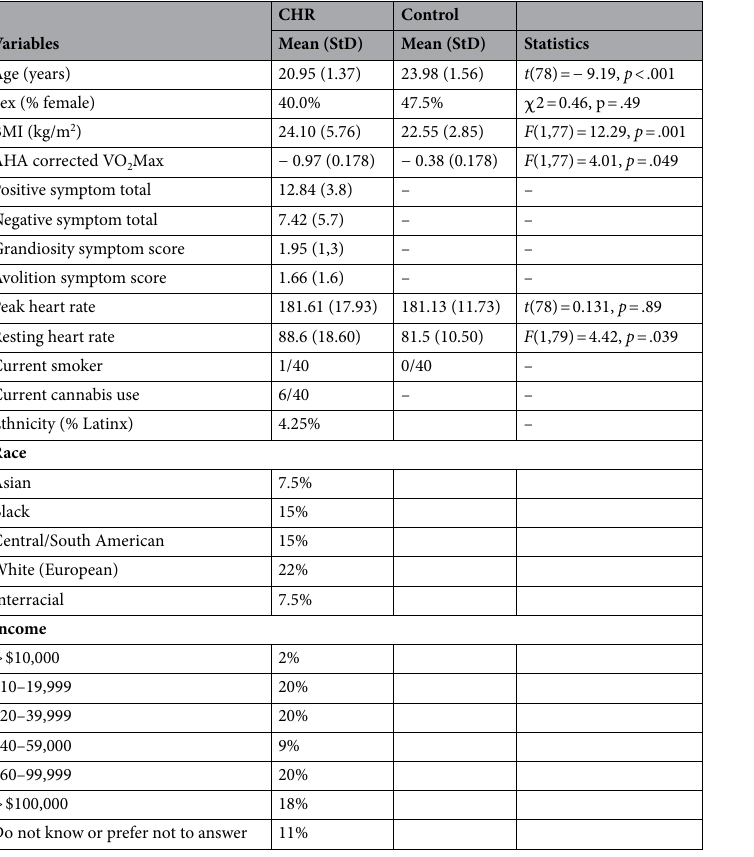
Table 1. Group demographics and objective exercise